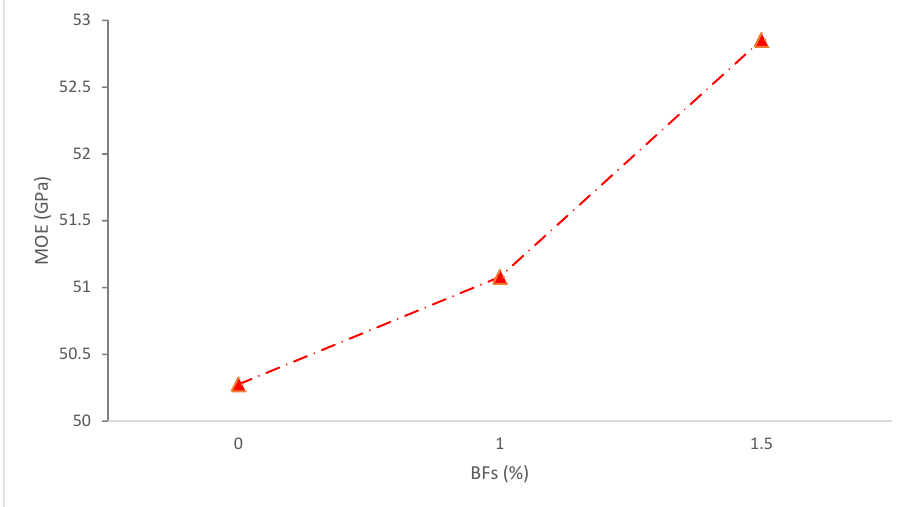
Figure 15. Elastic Modulus: Data Source [84].